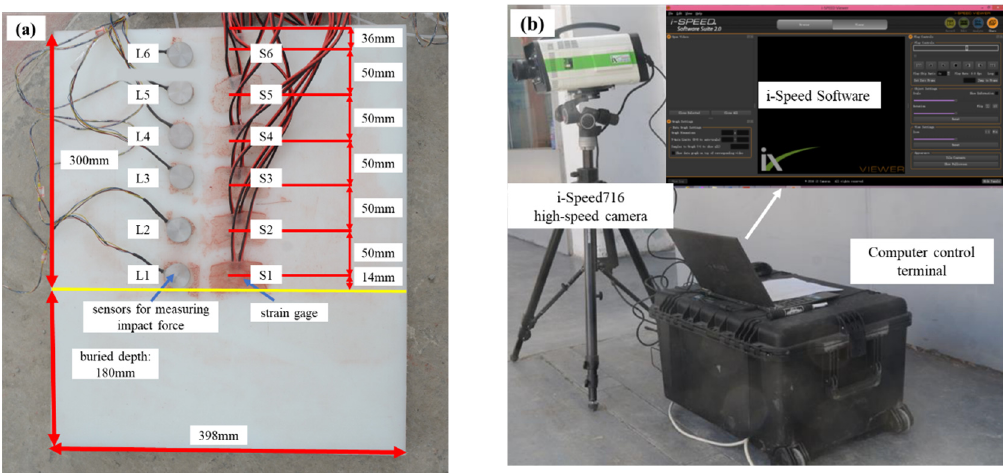
Figure 2. ( a ) Impact loading sensors, strain gates, and distribution; ( b ) high-speed recording system.